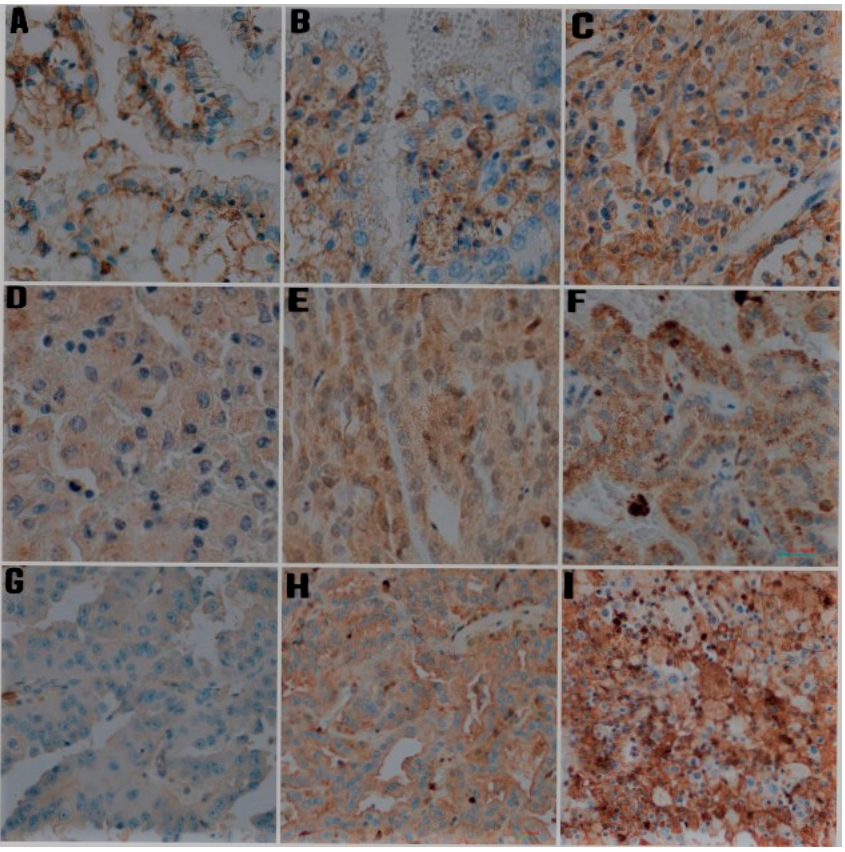
Figure 1. Representative photomicrographs of immunohistochemical staining for CD44, MMP-2, and MMP-9 in papillary renal cell carcinoma (IHC, ×400). ( A ) Weak staining intensity for CD44, ( B ) intermediate staining intensity for CD44, ( C ) strong intensity for CD44, ( D ) Weak staining intensity for MMP-2, ( E ) intermediate staining intensity for MMP-2, ( F ) strong intensity for MMP-2, ( G ) Weak staining intensity for MMP-9, ( H ) intermediate staining intensity for MMP-9, ( I ) strong intensity for MMP-9.